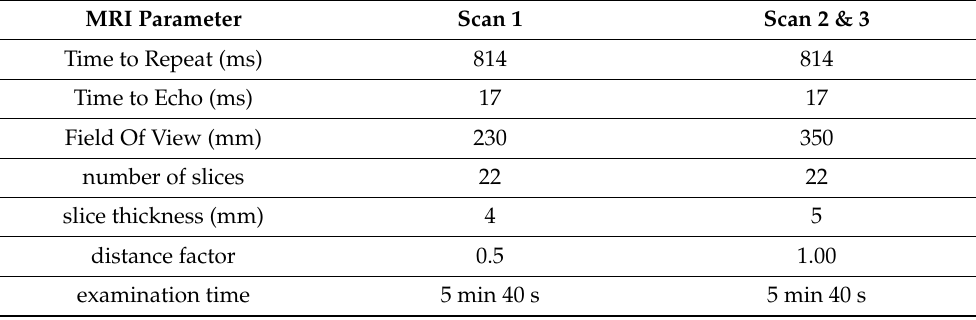
Table 1. MRI parameters for the coronar T1-weighted sequence, divided into the examination times.